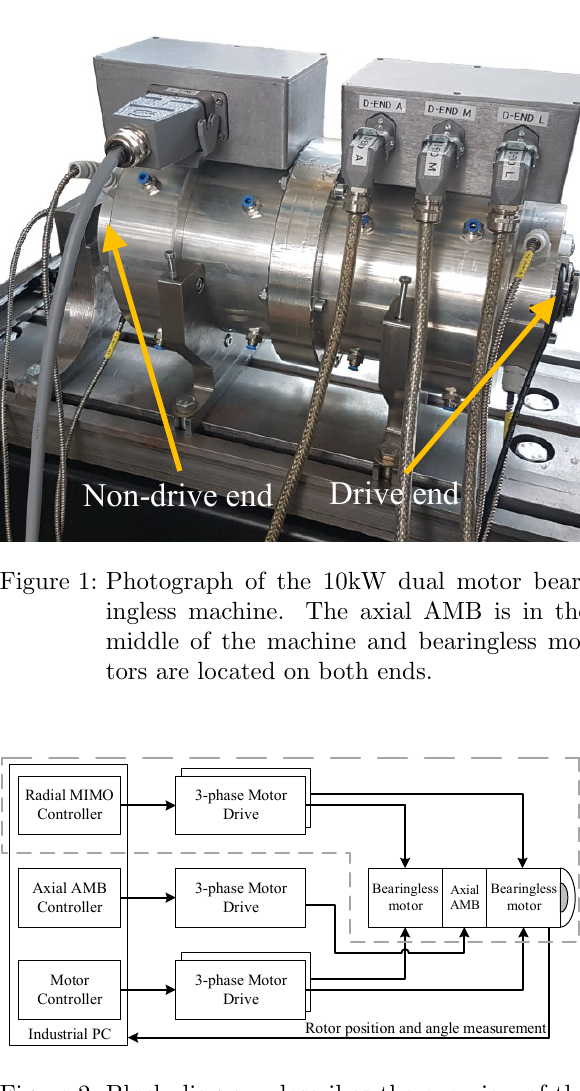
Figure 2: Block diagram describes the overview of the system configuration. All controllers are im- plemented on a Beckhoff industrial PC shown in far